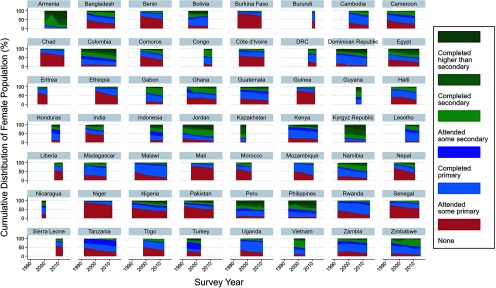
Changes in the Distribution of Educational Attainment Among Female Population 6 Years and OlderGraph area varies by the number of surveys and intervals between them.Source: DHS Program Application Programming Interface (API), available at http://api.dhsprogram.com/.